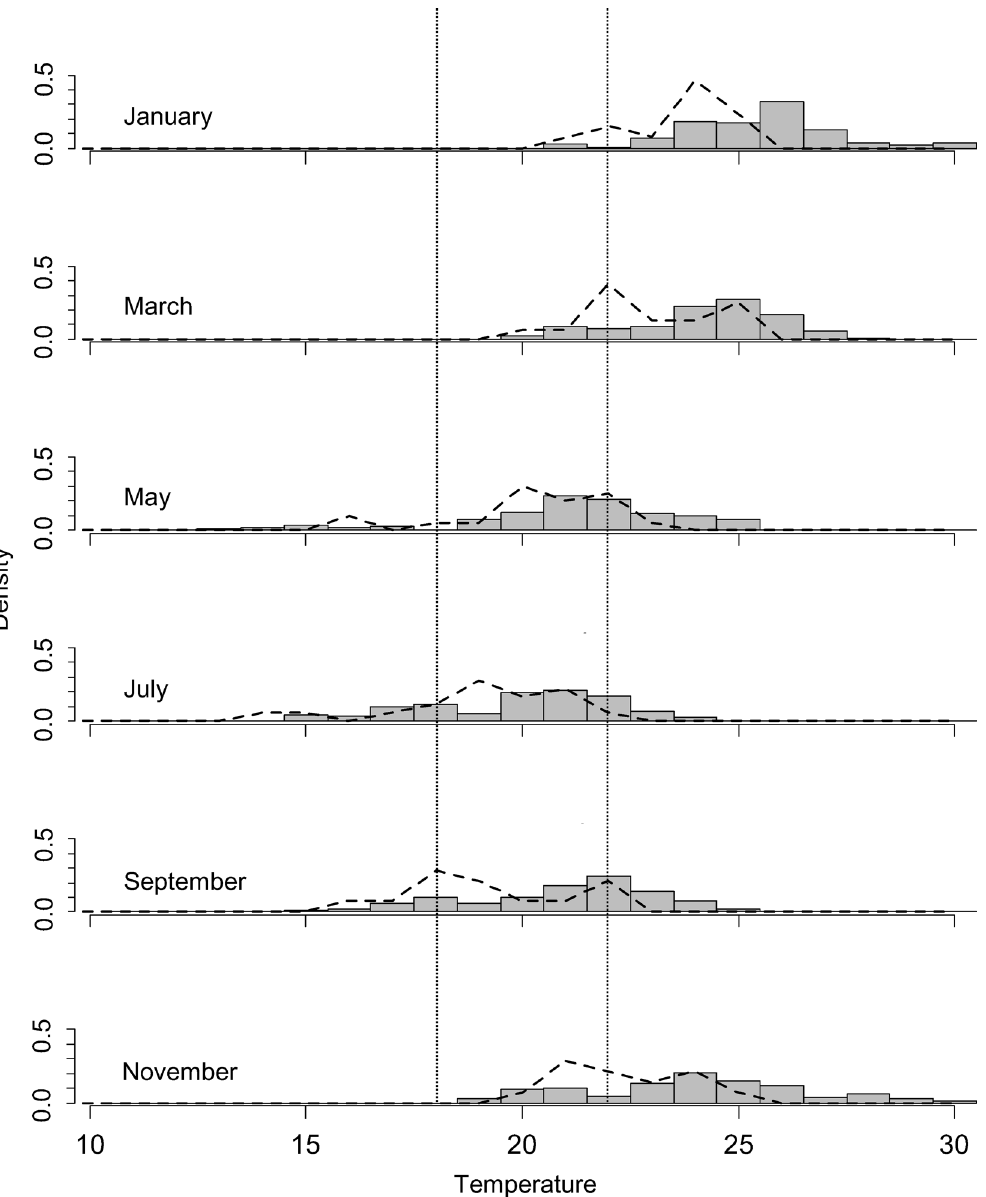
Fig 3. Minimum habitat temperatures of Carlia longipes . Density distribution of habitat temperatures (histograms) and minimum temperatures recorded by the Bureau of Meteorology (dashed lines) at different times of year. Habitat temperatures represent records collected at 5 am every day (coldest time of day) over a two-week period in eight different microhabitats representative of the locations that Carlia longipes is commonly observed in. Vertical dotted lines show acclimation regime used in this